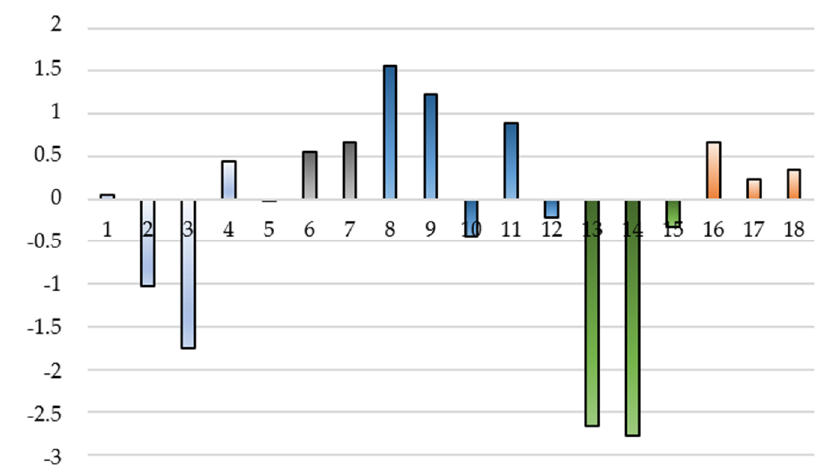
Figure 11. Results of Servqual perception analysis—expectations. Source: own study.